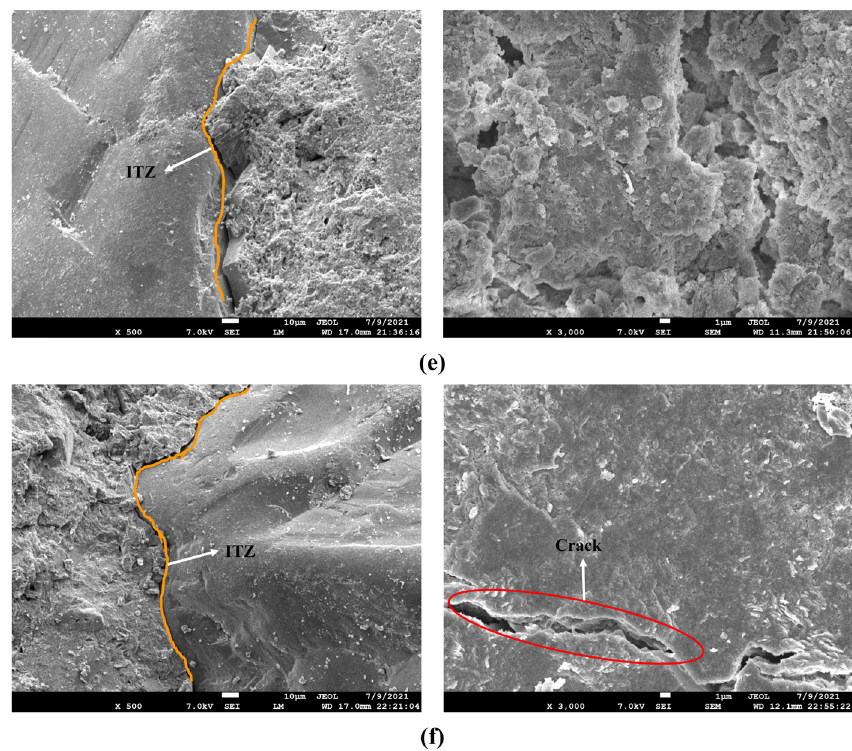
Figure 8: Micromorphology of the RAC: ( a ) RAC - 0 - 0N, ( b ) RAC - 0 - 100N, ( c ) RAC - 40 - 0N, ( d ) RAC - 40 - 100N, ( e ) RAC - 100 - 0N, and ( f ) RAC - 100 -